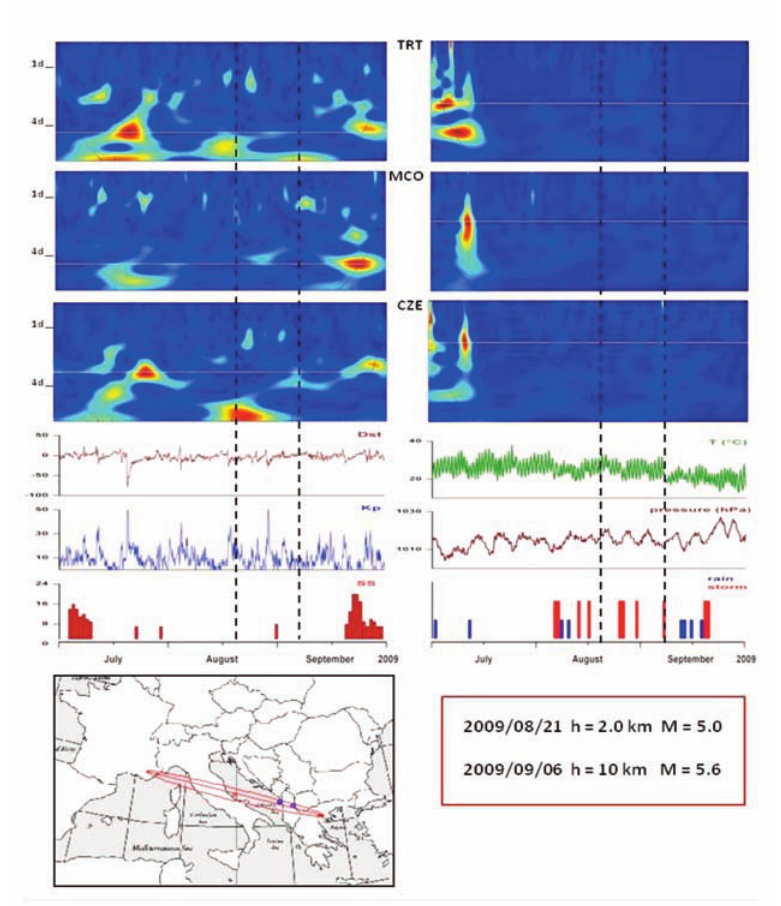
Figure 5. Night-time and day-time spectrograms of the TRT (180 kHz), MCO (216 kHz) and CZE (270 kHz) transmitter radio signals collected by the GR receiver, together with the geomagnetic/solar and the (local) meteorological data, from July to September 2009. Top panels: Spectrograms of the night- time (left) and day-time (right) radio signals. Continuous black lines, delimitation of the region (COI) of the wavelet spectra in which edge effects become important (Torrence and Compo, 1998). Centre panels: Dst and Kp geomagnetic indices and solar burst numbers (SS) (left), and air temperature, air pressure and occurrence of rain and storms (right). Bottom: map showing the 5th Fresnel zone of the GR/MCO path, showing the epicentres of the August 21 and September 6, 2009, earthquakes that occurred inside these zones. Vertical dashed lines, time of occurrence of these